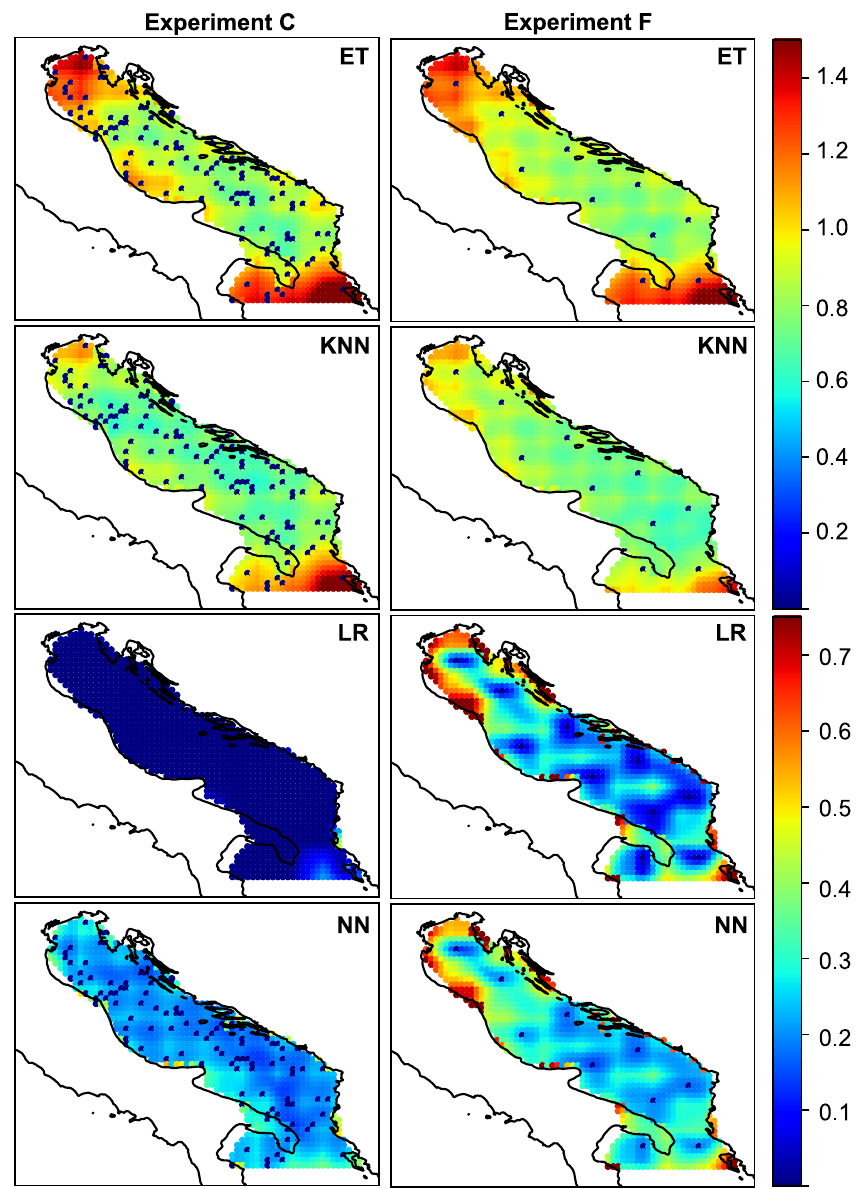
Figure 5. Spatial distribution of amplitude error for randomly distributed 110 sensors— experiment (c)—and for intelligent selection of the 10 sensors-experiment